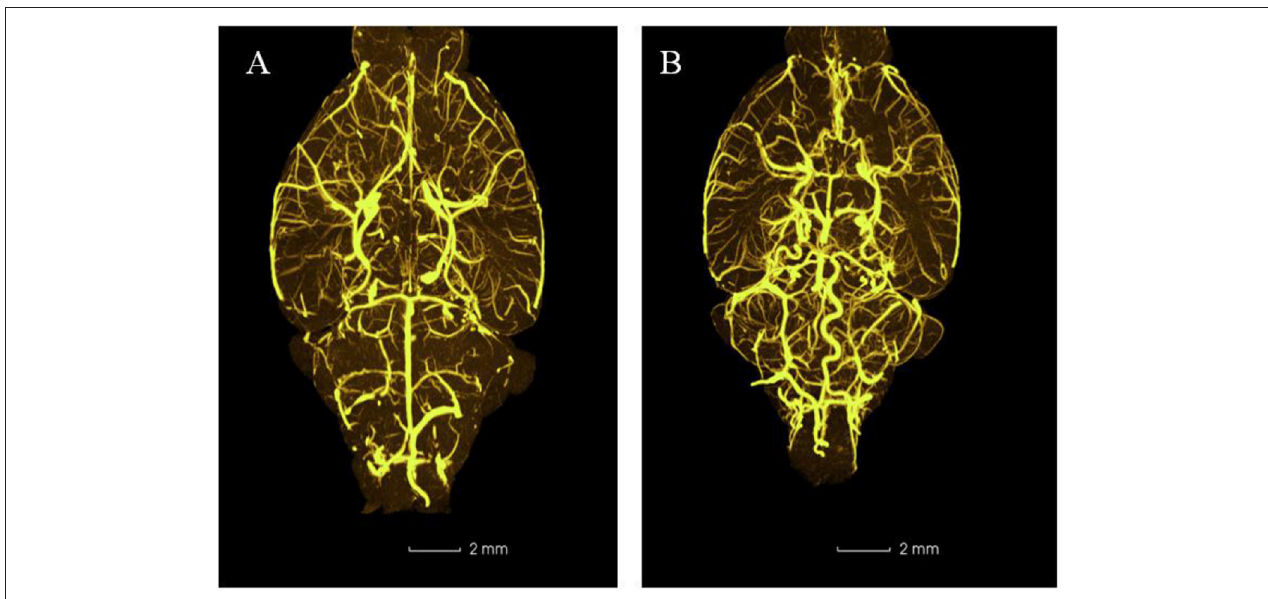
FIGURE 5 | Representative three-dimensional images of mouse intracranial arteries (100 × ) ( n = 5). (A) Control group; (B) Experimental